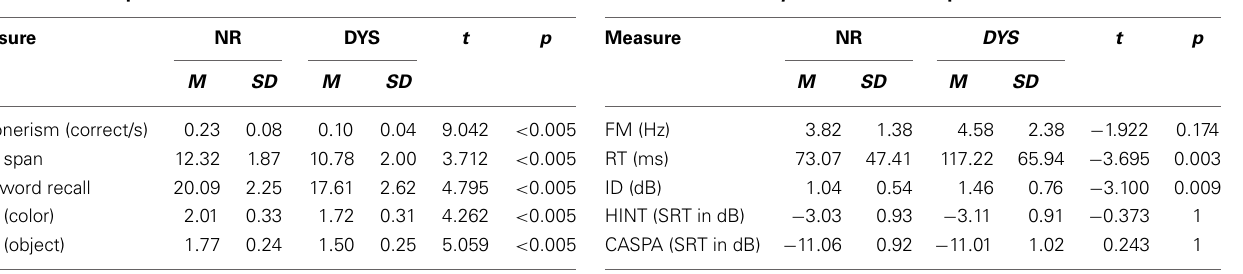
Table 2 | Phonological abilities: descriptive statistics and t- and p -values from independent t -tests.